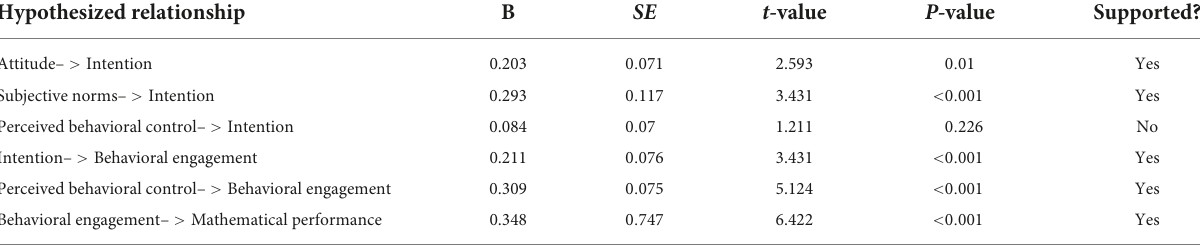
TABLE 5 Test results of mediation